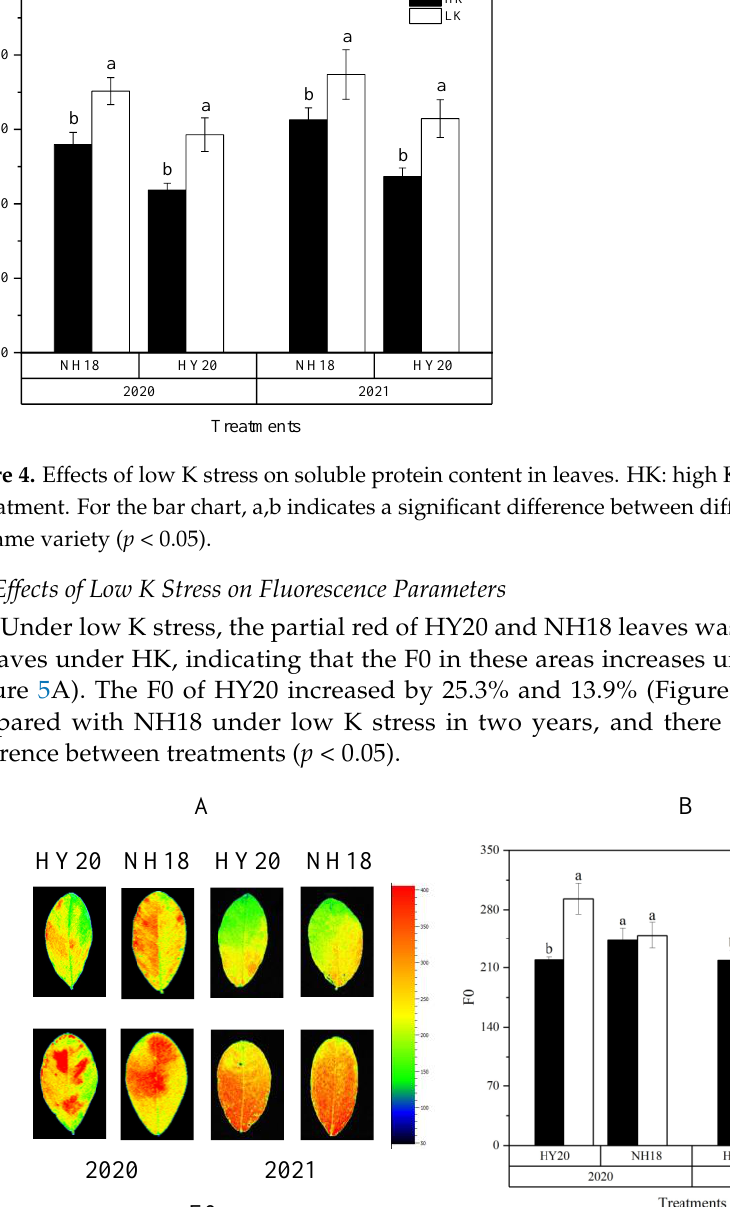
T r ea t m e n t s Figure 3. Effects of low K stress on MDA content in leaves. HK: high K treatment; LK: low K treatment. For the bar chart, a,b indicates a significant difference between different treatments for the same variety( p < 0.05). 3.4.2. Effects of Low K Stress on Soluble Protein Content in Leaves The soluble protein content in the peanut leaves under low K stress was higher than that under the high K treatment (Figure 4). Compared with the HK treatment, the protein